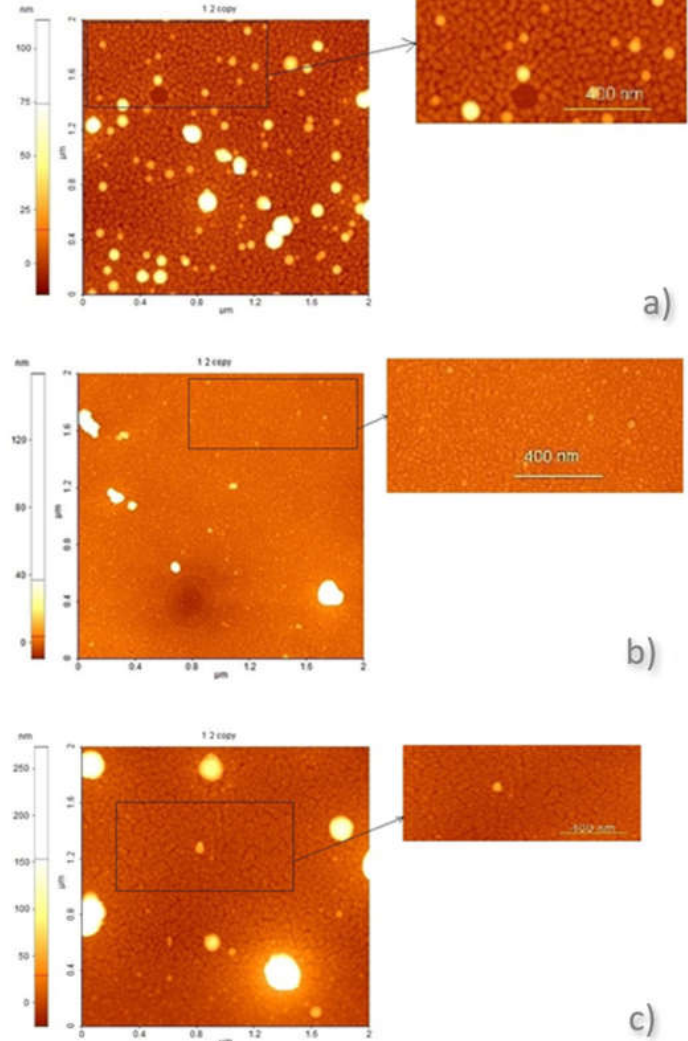
Figure 3. AFM images of Au layers deposited onto PMMA/quartz in ( a ) 1 Torr Ar, using 10,000 pulses (same as sensor S2); ( b ) 4 Torr, using 10,000 pulses (same as sensor S3); ( c ) 4 Torr Ar, using 30,000 pulses (same as sensor S4).